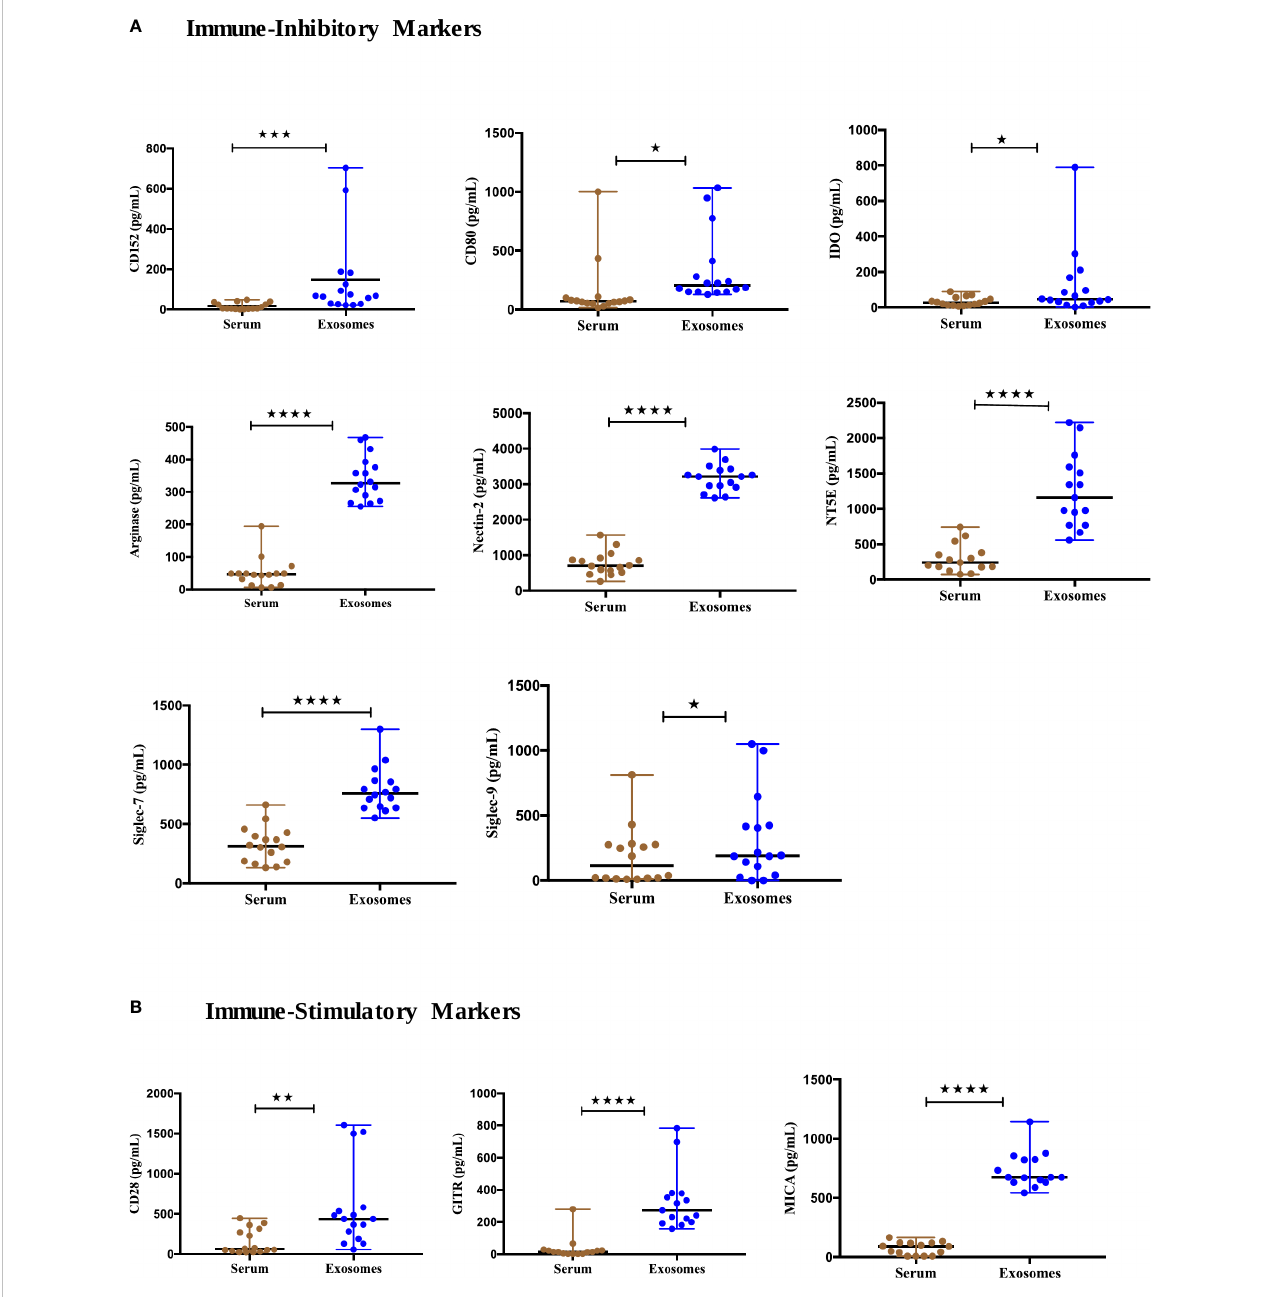
FIGURE 4 Expression of immune-oncology biomarkers from circulating exosomes compared to their soluble forms in serum of NSCLC patients. (A) Signi fi cantly higher Immune inhibitory protein levels (B) Signi fi cantly higher Immune-stimulatory protein levels in serum-derived exosomes of NSCLC patients (n=17) compared to their levels in serum. Two-tailed Wilcoxon matched-pairs signed rank test (*p<0.05, **p<0.01, ***p<0.001,